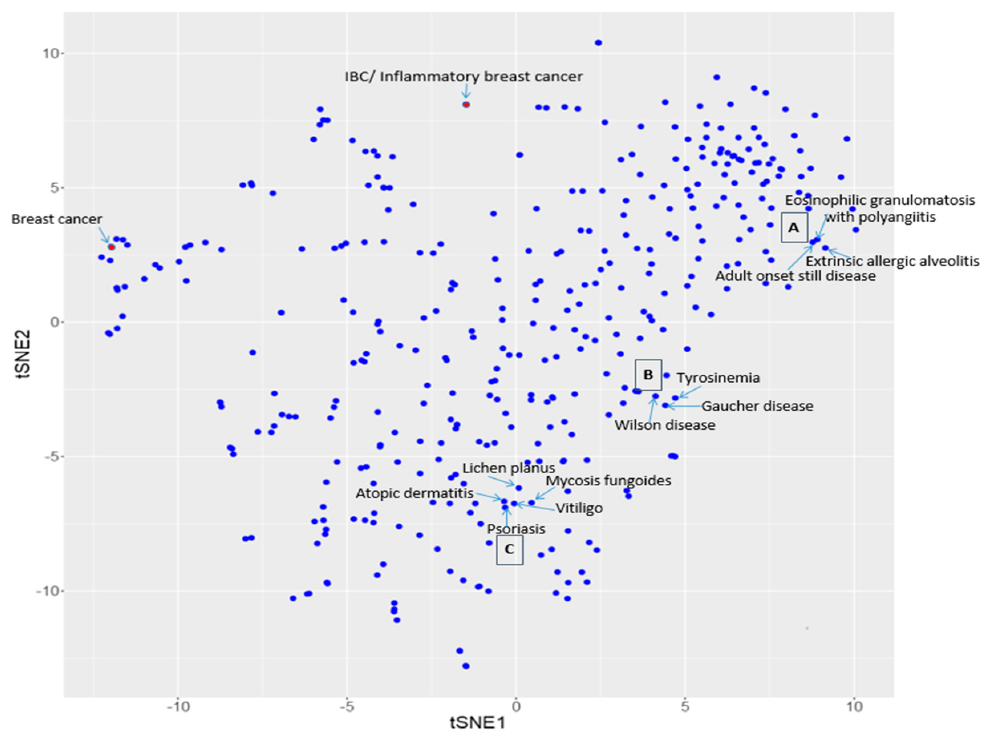
Figure 1. Breast cancer, inflammatory breast cancer (IBC), and three annotated disease clusters on the disease similarity map.